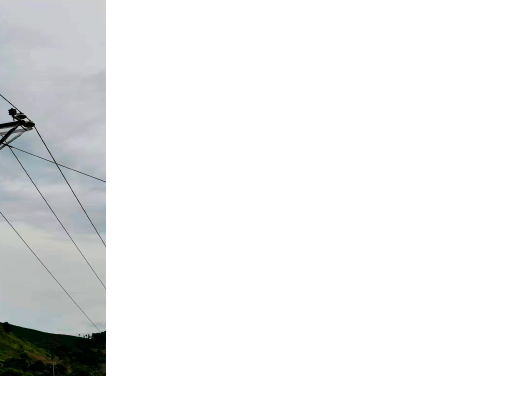
Figure 10. The hanging network operation of the air ‐ blown interrupting gap. ( a ) Single ‐ phase; ( b ) Three phase. ( b ) Three phase.